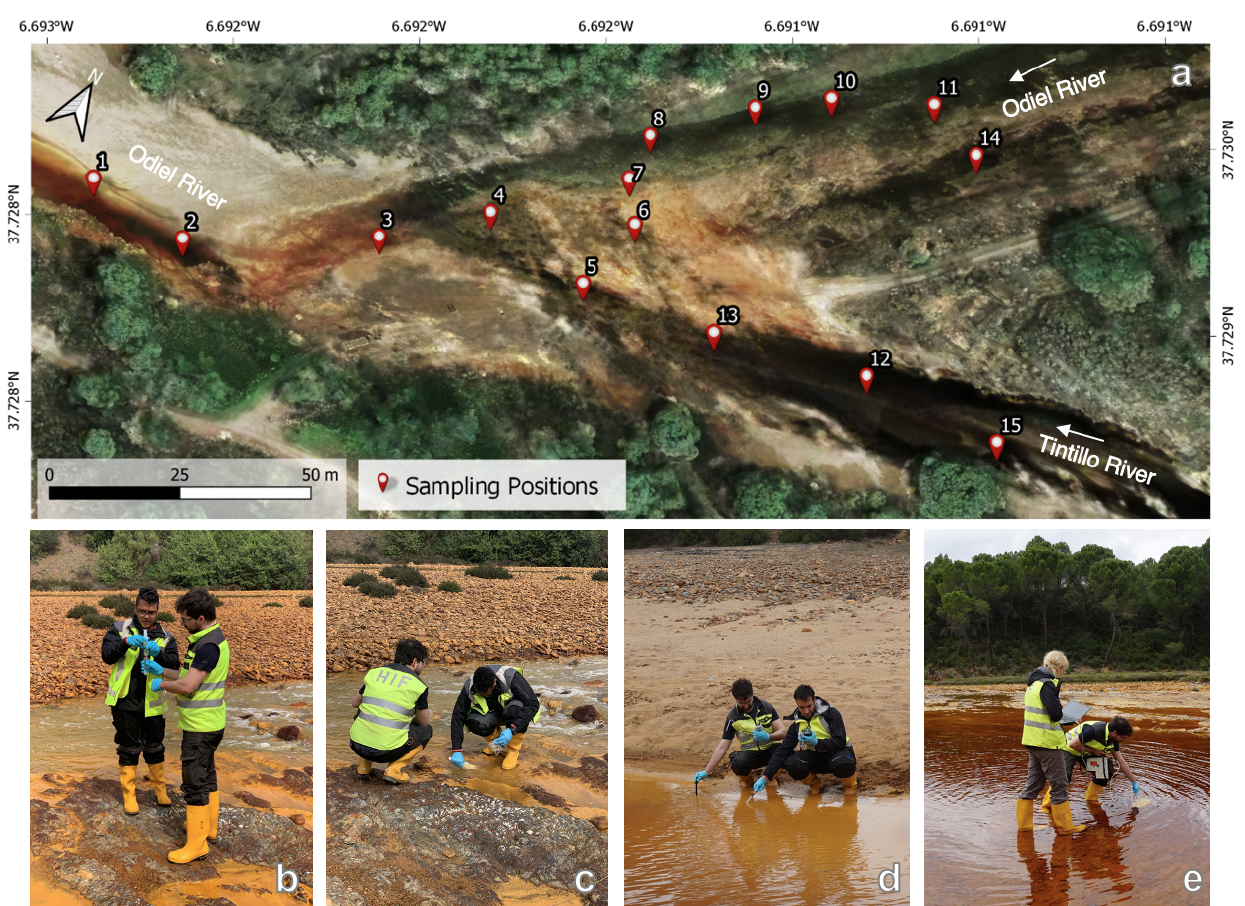
Figure 4. Field sampling strategy: ( a ) geographical location of the sampled spots, ( b ) water sampling, ( c ) sediment sampling and in-situ measurement of ( d ) pH, temperature, redox, and ( e ) spectroscopy on the river